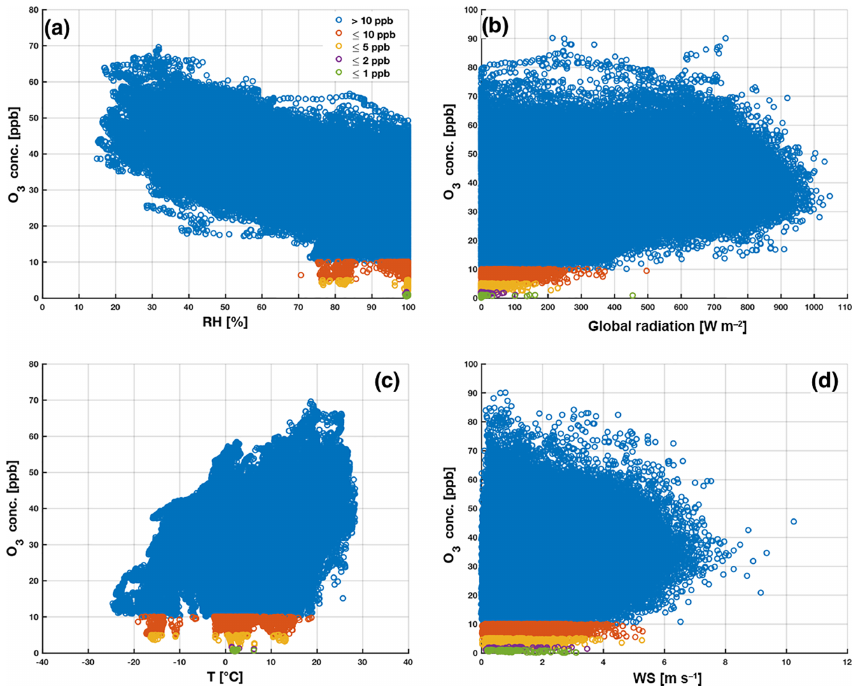
Figure 7. Ozone concentrations vs. (a) relative humidity (RH), (b) global radiation, (c) temperature ( T ), and (d) wind speed. Plots are made with 10min data collected from the 16.8m measurement level during the period 1996–2016, with an exception of the global radiation data from